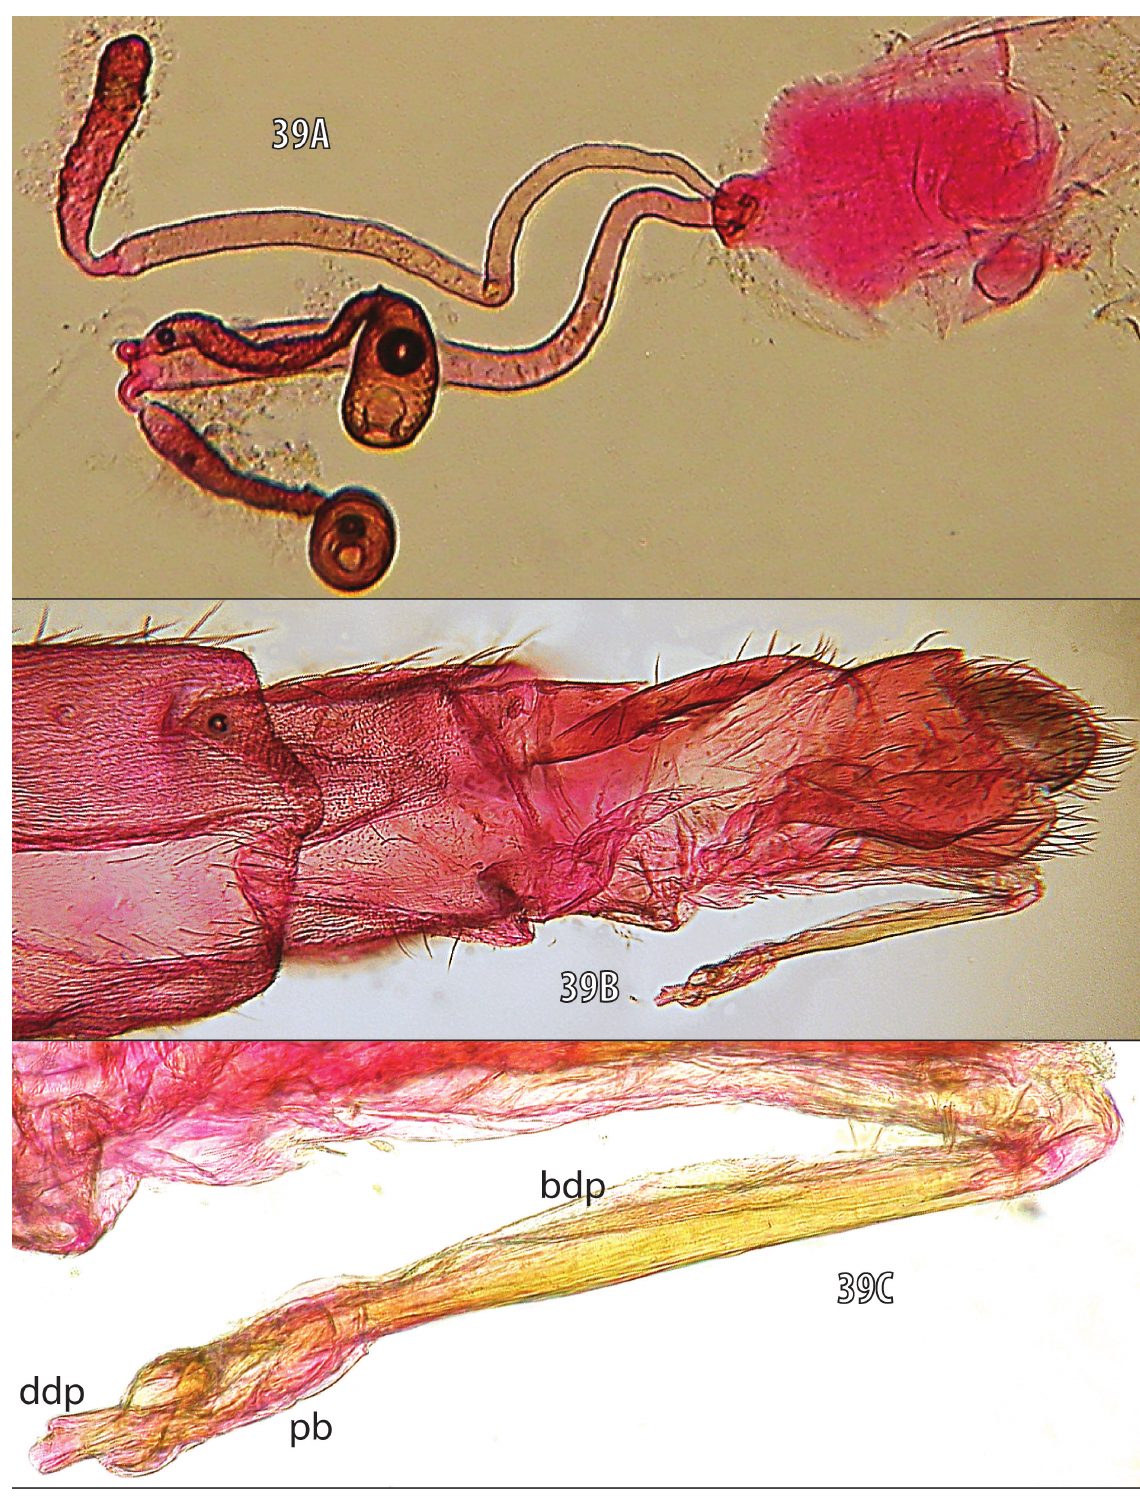
Fig. 39. Mesoconius zorro sp. nov., internal characters. A . Spermathecae and associated structures. B . Male abdomen, left side. C . Phallus. Abbreviations: bdp = basal distiphallus; ddp = distal distiphallus; pb = phallic